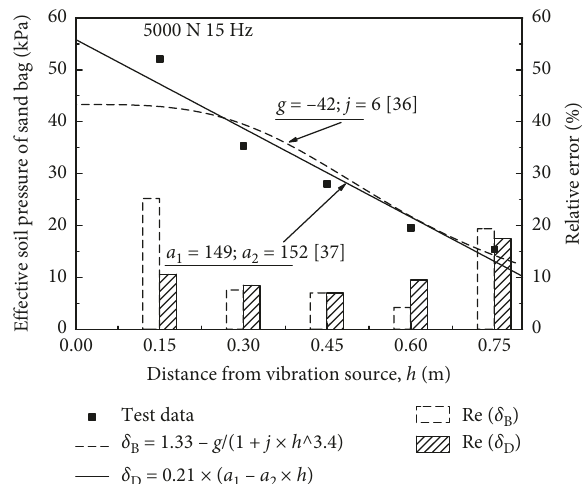
Figure 15: Test results and empirical formulae at different mea- surement points in the case of a single jack (sand bag).